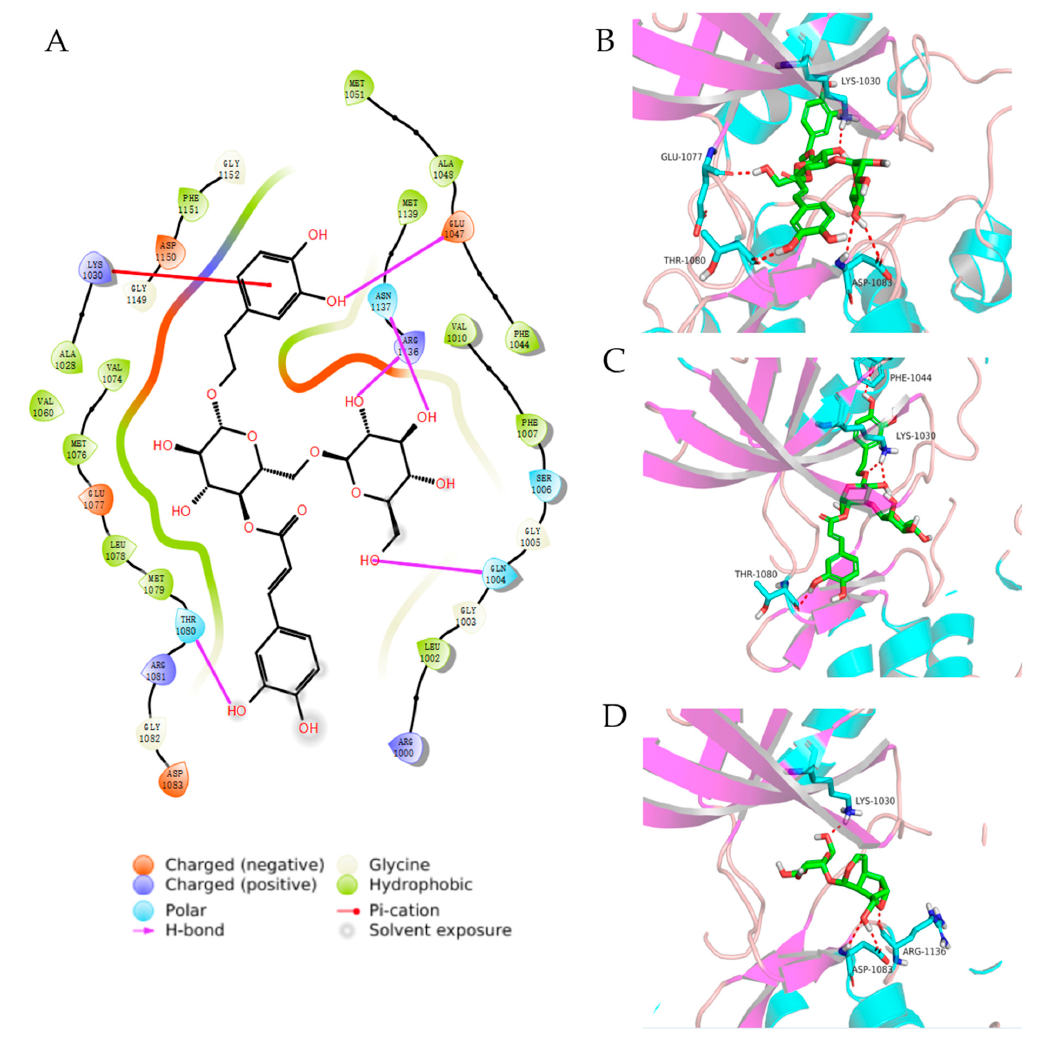
Figure 8. Predicted binding mode of ECH_rm_both_sugar ( A,B ), ACT ( C ) and CAT ( D ) with